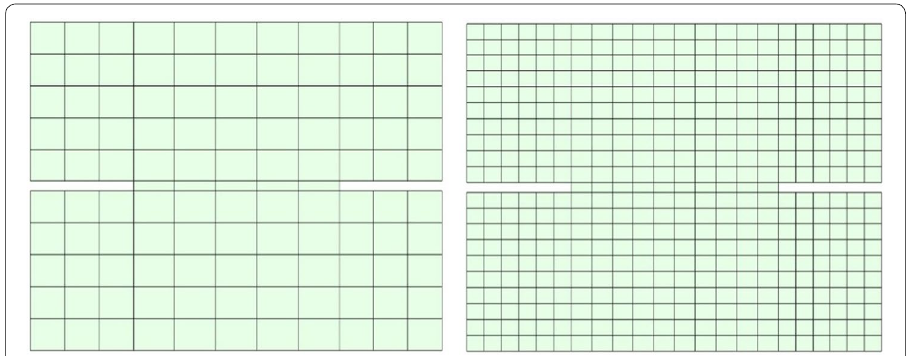
Fig. 8 Finite element meshes used, namely Mesh1 (left) and Mesh2 (right)